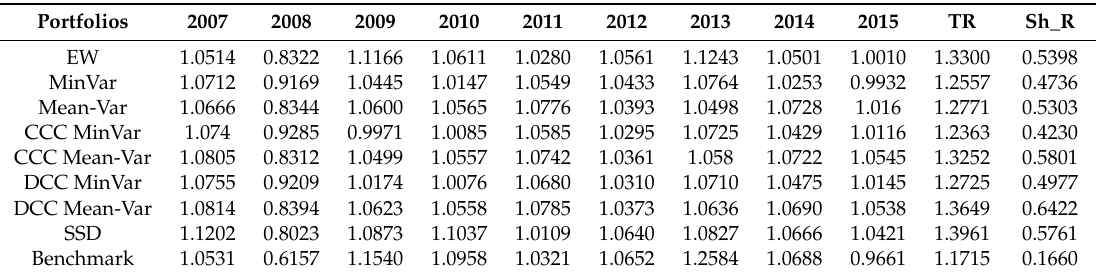
Table 3. Yearly compounded returns, Total compounded Return (T_R) and Sharpe Ratio (Sh_R) for DJ stocks (t = 750).